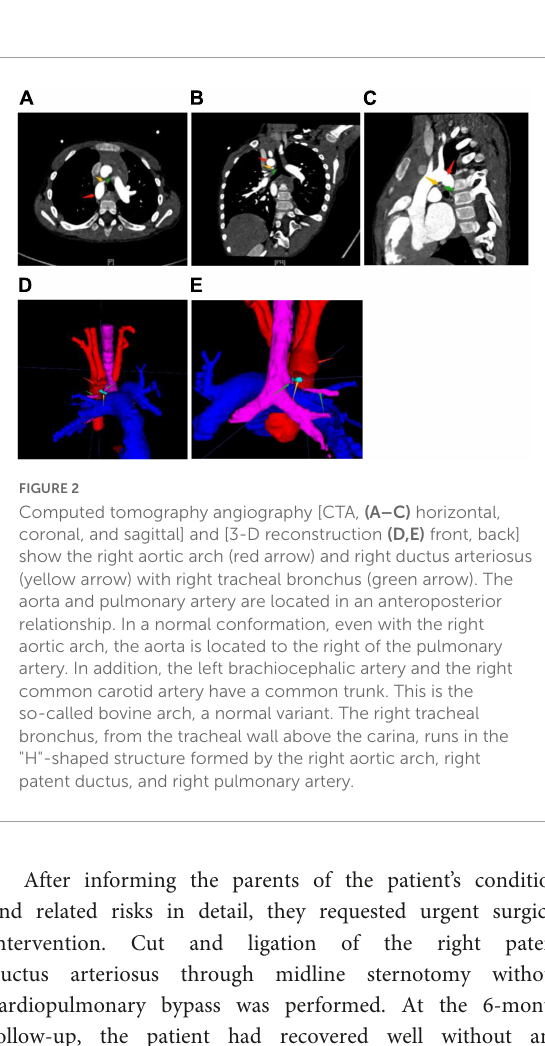
After informing the parents of the patient’s